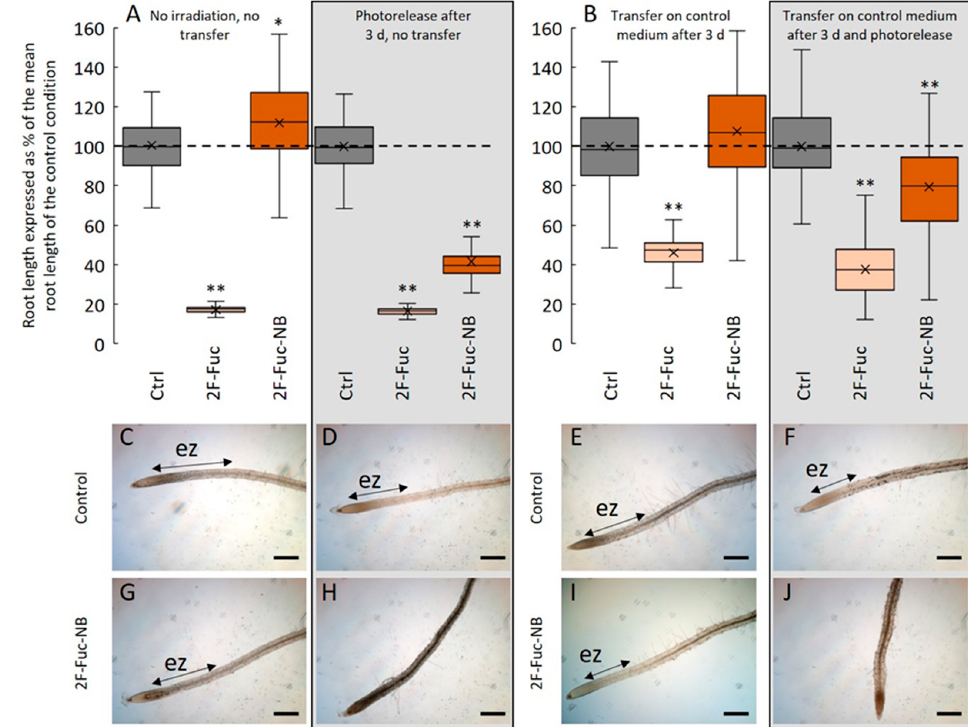
Figure 5. 2-F-Fuc-NB is incorporated in root cells before photolysis. ( A ): Effect of 5 µM of 2F-Fuc or 2F-Fuc-NB on the root length with (boxed) or without photolysis. ( B ): Effect of 5 µM 2F-Fuc or 2F-Fuc-NB on the root length after transfer on the control medium followed by photolysis (boxed) or not. C to J : Representative pictures of Arabidopsis roots after 7 days in control conditions ( C , D ) or in a medium supplemented with 5 µM of 2F-Fuc-NB ( G , H ) without ( C , G ) or with ( D , H ) photolysis after 3 days. ( E , F ): Representative pictures of Arabidopsis roots after 3 days of growth followed by a transfer on a new control medium and 4 more days of growth in the control condition with ( F ) or without ( E ) photolysis after the transfer. ( I , J ): Representative pictures of Arabidopsis roots after 3 days of growth on a medium supplemented with 5 µM 2F-Fuc-NB followed by a transfer on the control medium and 4 more days of growth in the control condition with ( J ) or without ( I ) photolysis after the transfer. Scale bars: ( C – J ): 200 µm. ez: elongation zone. Dashed line in ( A , B ) represents the mean root length in control conditions. ** indicates statistically significant differencesfrom the control condition ( p < 0.01).